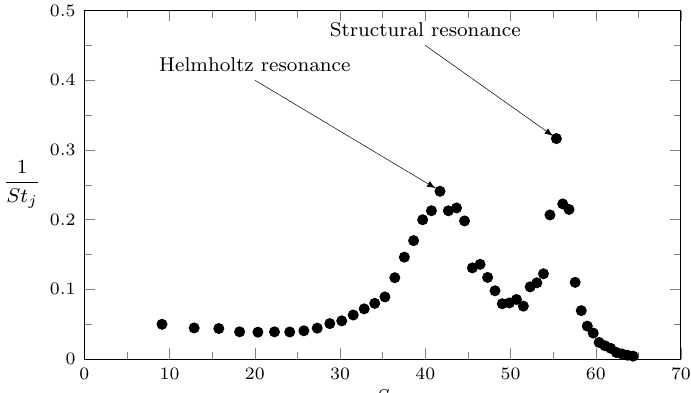
Figure 6. Frequency response of the manufactured double-orifice actuator: experimental Strouhal number St j as a function of the Stokes number S . The resonance peaks (modified structural and Helmholtz frequencies) are